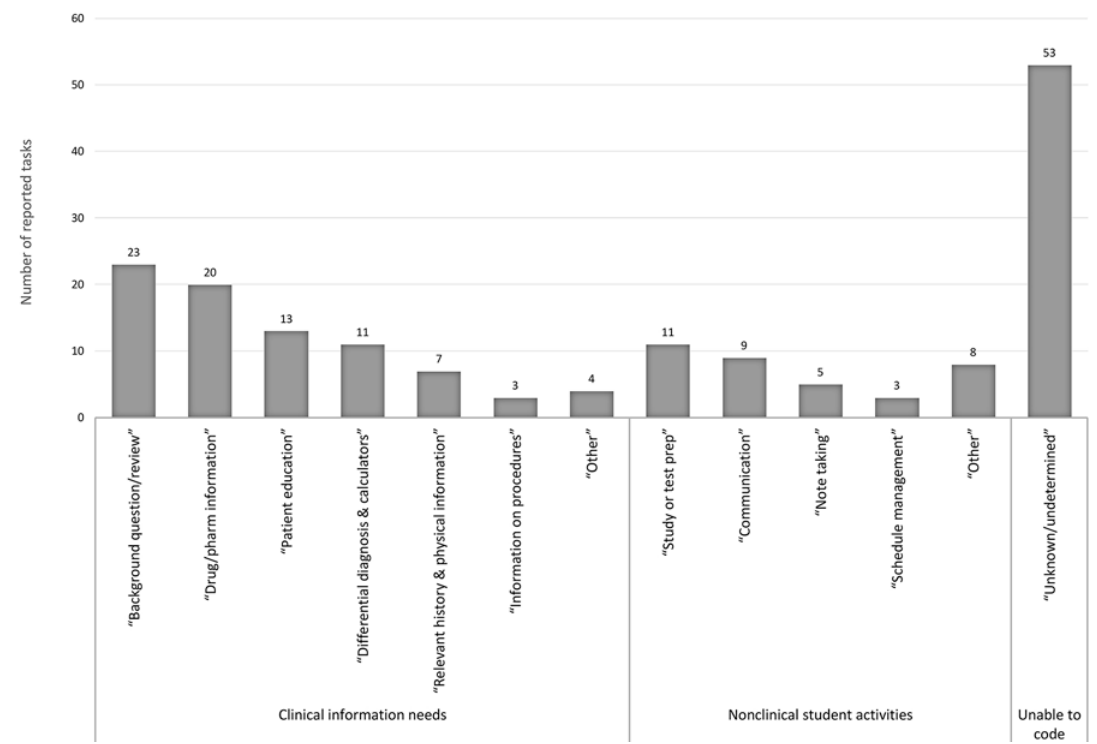
Figure 1 Participant iPad mini tasks (structured learning journal [SLJ] reported